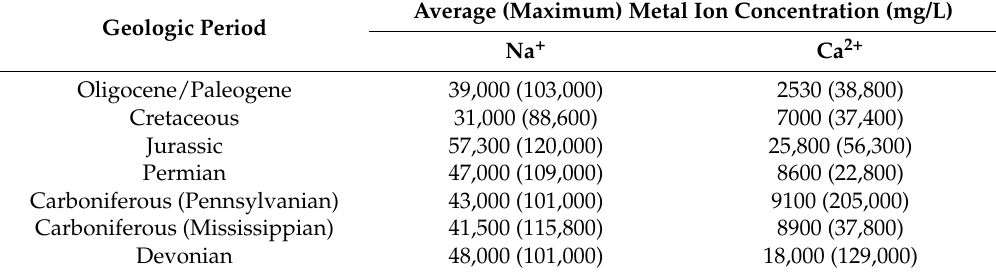
Table 2. Na + and Ca 2+ compositions of formation waters from different geologic periods. For